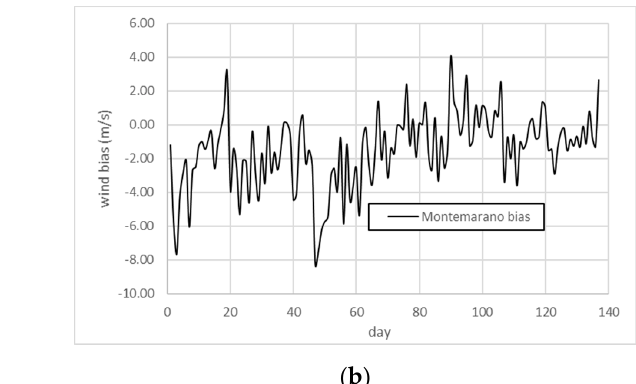
Figure 9. Vertical profiles of speed (a-c) and direction (b-d) bias for each hour on 6 March 2018 (a-b) and 23 April 2018 (c-d).